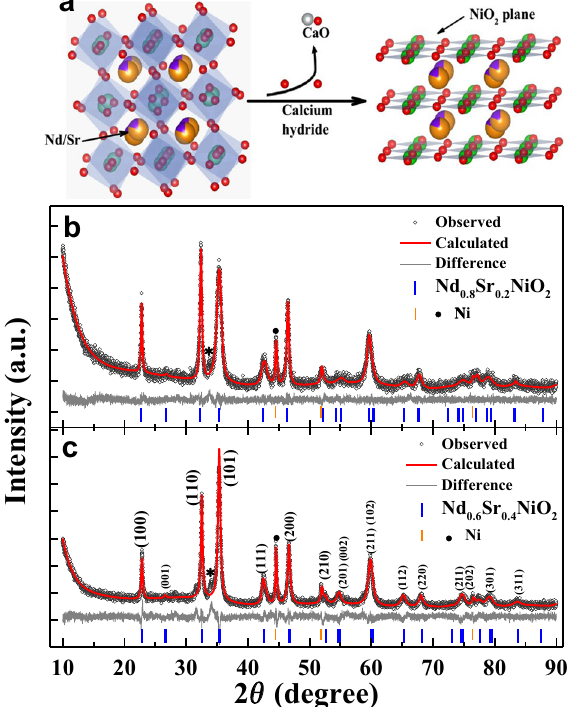
Fig. 1 Crystal structure and Rietveld re fi nement analyses. a The schematic structure and transformation from perovskite Nd 1 − x Sr x NiO 3 to in fi nite-layer Nd 1 − x Sr x NiO 2 by low-temperature reduction process with CaH 2 . b, c Powder X-ray diffraction patterns of Nd 0.8 Sr 0.2 NiO 2 and Nd 0.6 Sr 0.4 NiO 2 (circles) and Rietveld fi tting curves (red lines) to the data. A small impurity peak around 33 degree marked with asterisk (*) in both samples may come from the unreacted (Nd,Sr) 2 NiO 4 phase. The Miller indices of Nd 0.6 Sr 0.4 NiO 2 sample are given in